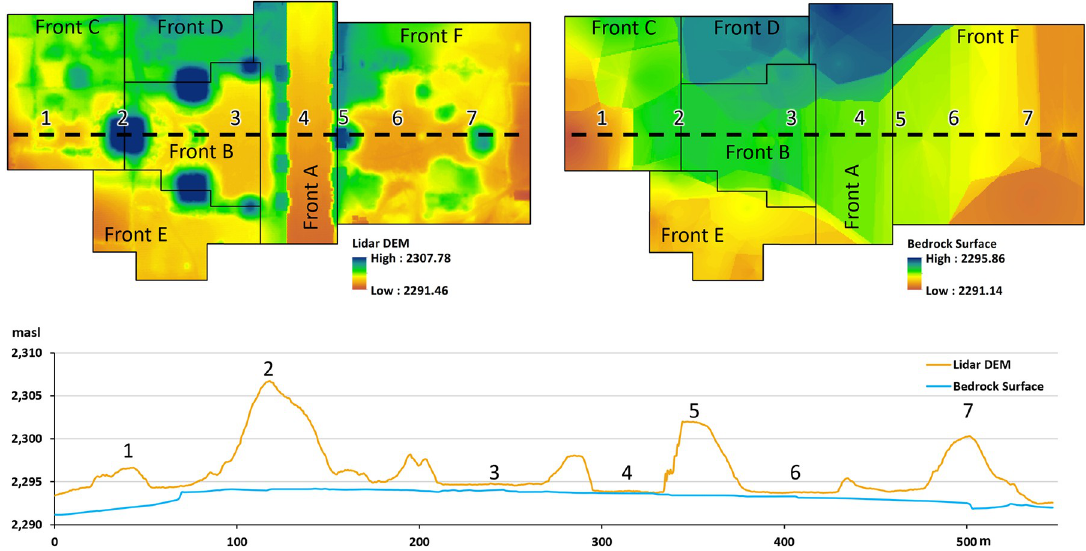
Fig 8. Artificial ground volume calculation methodology. Upper left: Lidar DEM indicating the topography (height in masl). Upper right: Bedrock surface model based on excavations at Plaza of the Columns Complex. Below. Profile of #1 and #2 used to calculate volume. Note abrupt cut in bedrock in region 1. Map produced by T.